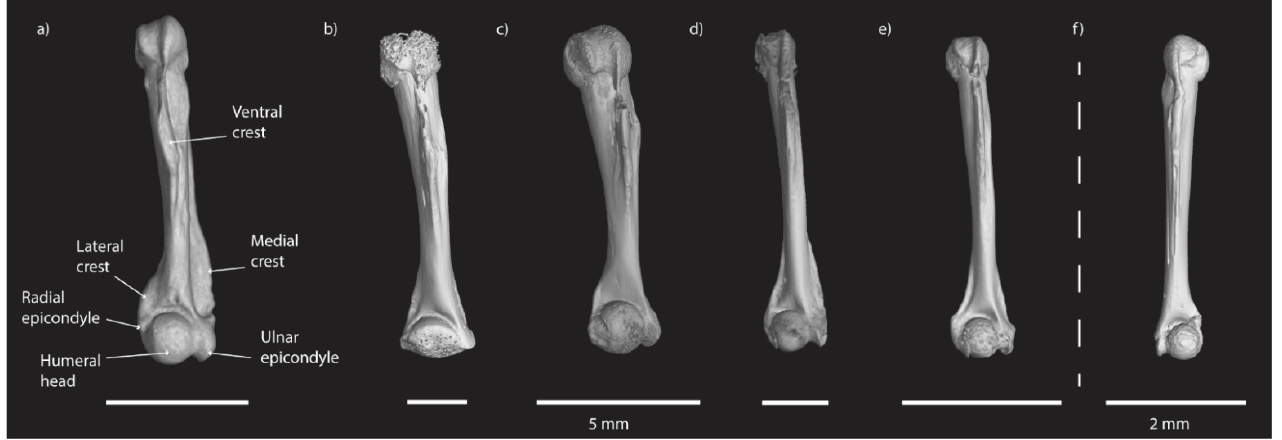
Figure 4. Humeri of anuran species used for comparison with fossil material. ( a ) Telmatobius carrillae ; ( b ) Rhinella marina ; ( c ) Pleurodema nebulosa; ( d ) Hyla boans ; ( e ) Gastrotheca nebulanastes ; ( f ) Psychrophrynella bagrecito . ( a – e ) Right humerus, scale bar = 5 mm; ( f ) left humerus, scale bar = 2 mm. [51] (Anatomical nomenclature). Composite image by Vallejo-Pareja from photographs of digitally segmented specimens (ct-scans) at the Herpetology Division of the Florida Museum of Natural History. Table 2. Number of Anura humeri from M70-2961 identified to the genus level by NISP and MNI (photos reproduced with permission: Rhinella sp. [54], Telmatobius sp. [55], and Pleurodema sp. [56]).